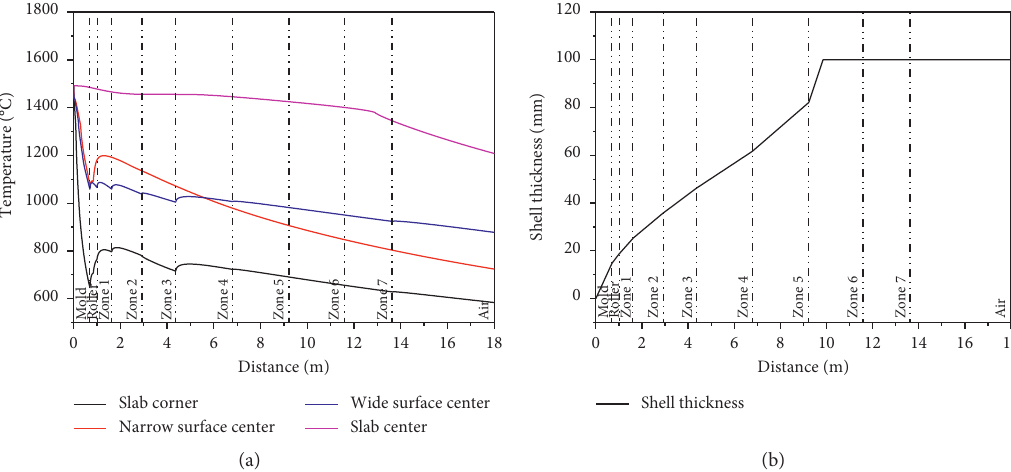
Slab corner Wide surface center Narrow surface center Slab center Figure 7: Temperature field simulation results. (a) Temperature change curves at characteristic positions. (b) The variable trend of thickness of the